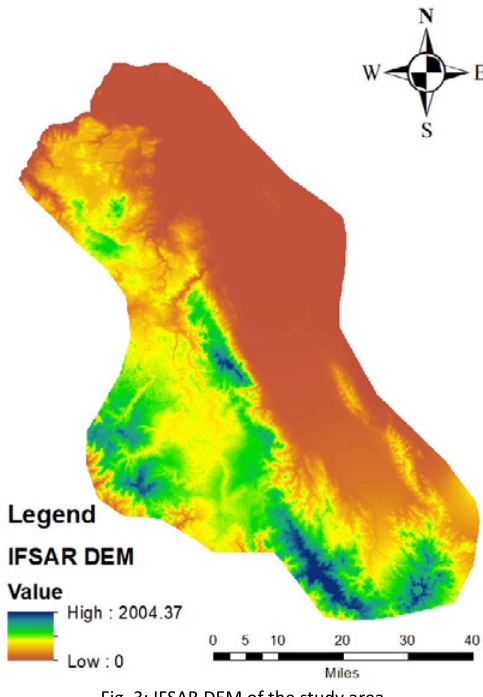
Fig. 3: IFSAR DEM of the study area